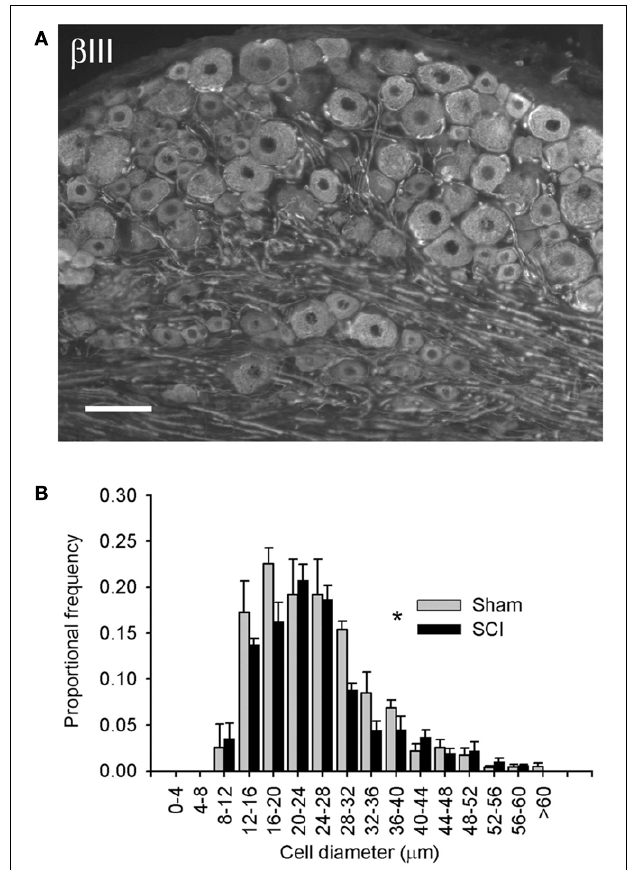
FIGURE 1 | High-thoracic (T3) spinal cord injury provoked hypertrophy of neurons in the L4/L5 dorsal root ganglion. (A) β III-tubulin immunohistochemistry illustrating neuronal profiles in the L5 DRG. (B) Size-frequency distribution of pooled L4/L5 DRG neurons, reconstructed from profile distributions using recursive translation. Ganglia were harvested 3months after sham-injury (gray) or completeT3 SCI (black). There was a small but significant rightward shift in size-frequency distribution in animals withT3 SCI ( P < 0.05, K–S goodness-of-fit test). Scale bar = 70 µ